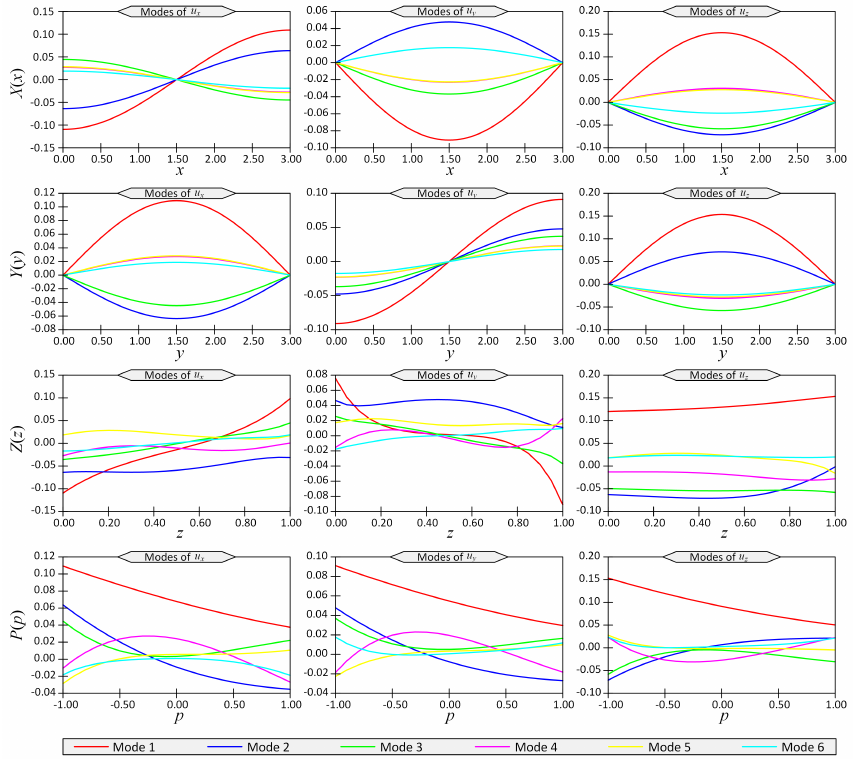
Figure 2. The first six modes of displacement components ( u x , u y , u z ) with respect to space coordi- nates ( x , y , z , p ) for Example 1 for boundary conditions case